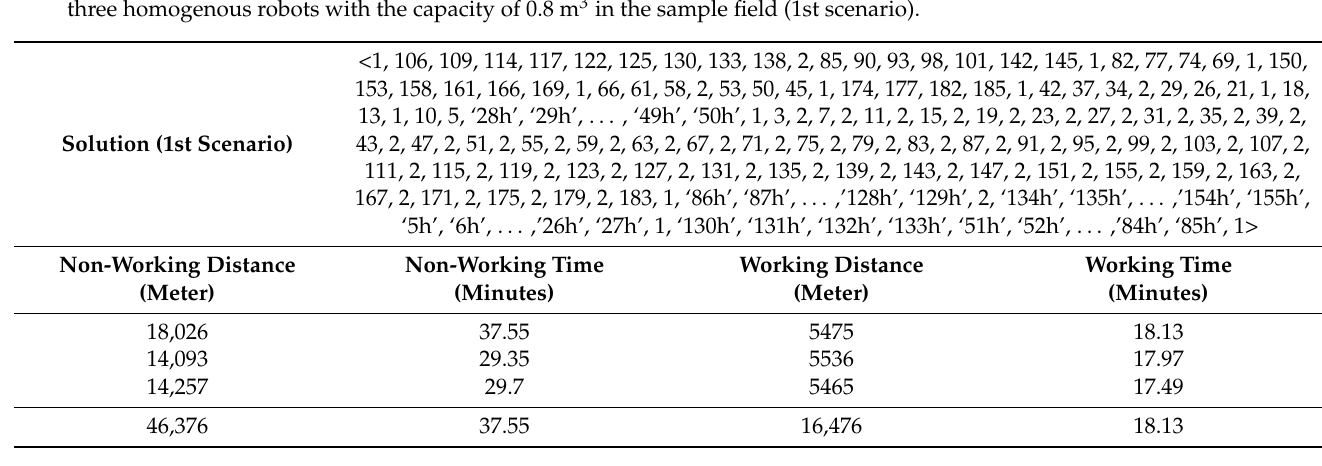
Table 6. The optimized field coverage plan with the results of the simulation model for the fertilizing operation by using three homogenous robots with the capacity of 0.8 m 3 in the sample field (1st scenario).